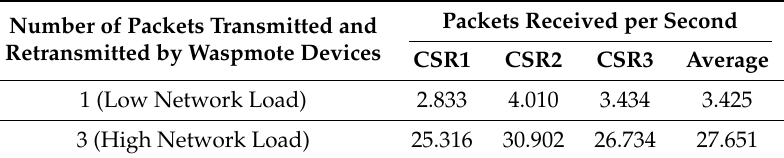
Table 18. Packets per second received by CSR devices when they retransmit each packet once. Waspmote devices configured as Collaborative